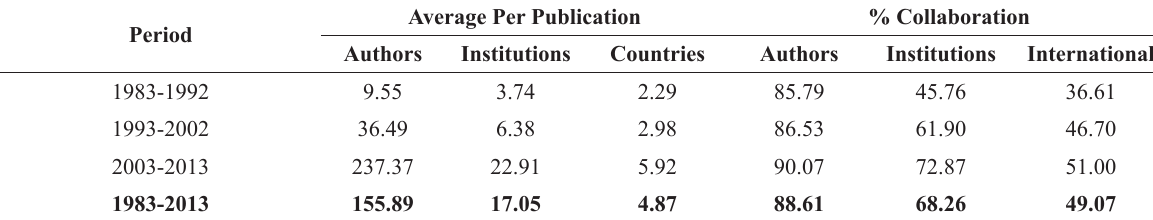
Summary of the main collaboration results for Brazilian HEP,